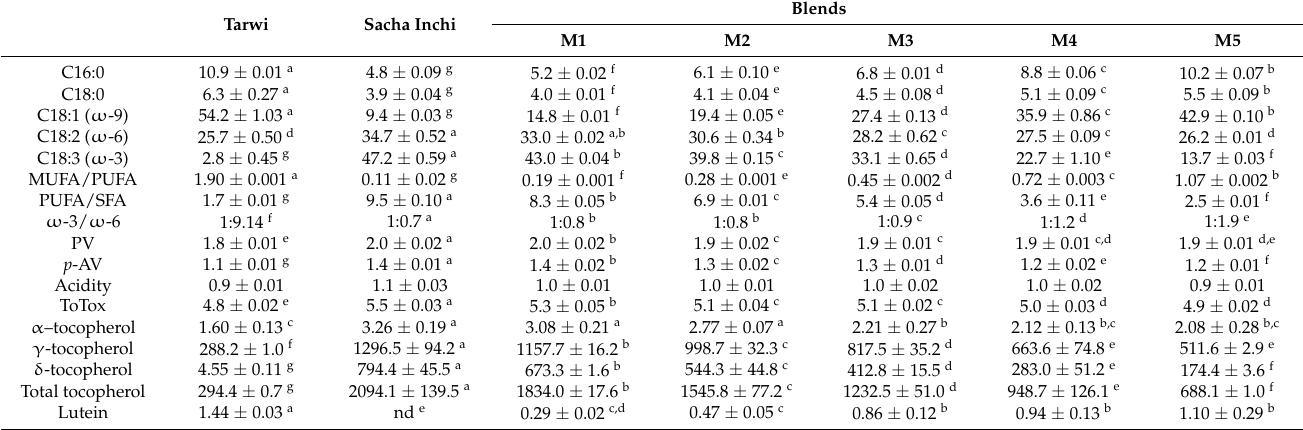
Table 1. Mean ( ± standard deviation) fatty acid composition (%), peroxide value (PV; meq active oxy- gen/kg oil); p -anisidine value ( p -AV); acidity (mg KOH/g oil); total oxidation value (ToTox = 2PV + p-AV); tocopherol and carotenoid content (mg/kg) of tarwi oil, sacha inchi oil, and their blends. Tarwi oil: Sacha inchi oil ratios ( w : w ) were 1:4 (M1), 1:3 (M2), 1:1 (M3), 3:1 (M4) and 4:1